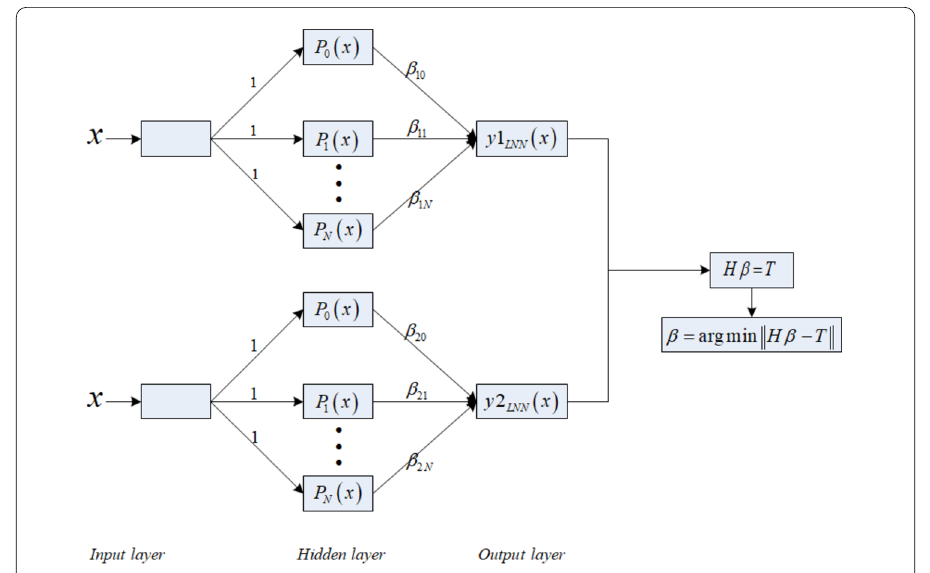
Figure 1 Neural network model for SODE based on Legendre polynomial